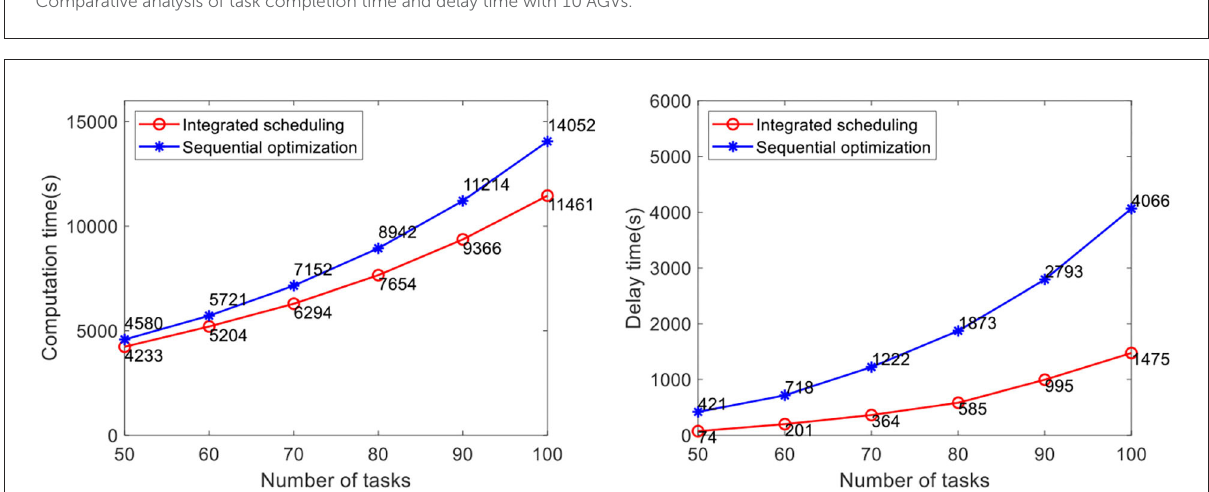
FIGURE12 Comparative analysis of task completion time and delay time with 15